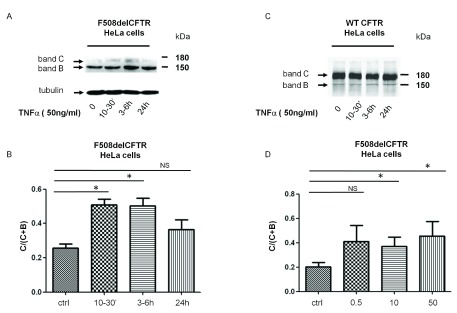
Immunoblot analysis of F508del-CFTR and WT-CFTR expression in HeLa cells.* indicates significant results.
A. F508del-CFTR expression after stimulation of cells with 50ng/ml TNFα for 10min, 3–6h and 24h. Band C refers to fully glycosylated F508del-CFTR, band B refers to core glycosylated F508del-CFTR.
B. Relative quantification of C/B+C indicating changes in maturation of F508del-CFTR after stimulation of cells with 50ng/ml TNFα for 10min, 3-6 and 24 h, p=0,0046, p=0,0234, p=0,69 (NS) for 10mins, 3–6h and 24 h, respectively.
C. WT-CFTR expression after stimulation of cells with 50ng/ml TNFα for 10min, 3–6h and 24h.
D. Concentration dependence of expression and the changes in maturation of F508del-CFTR in response to treatment of cells with 0.5, 10 and 50ng/ml TNFα, p=0.12 (NS), p=0.01, p=0.03, respectively.